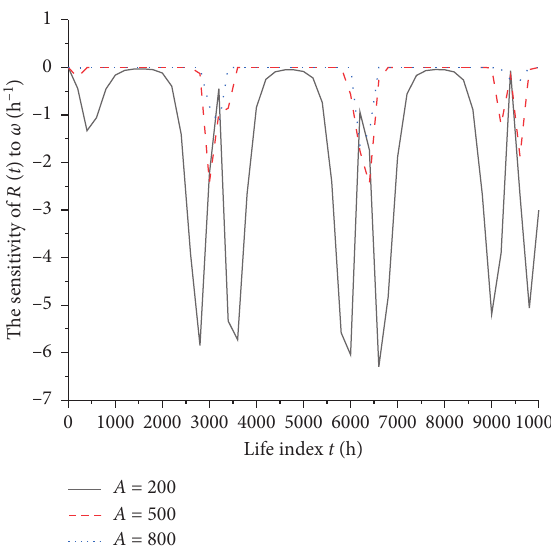
Figure 28: The sensitivity of R ( t ) to 2 ω ( A �